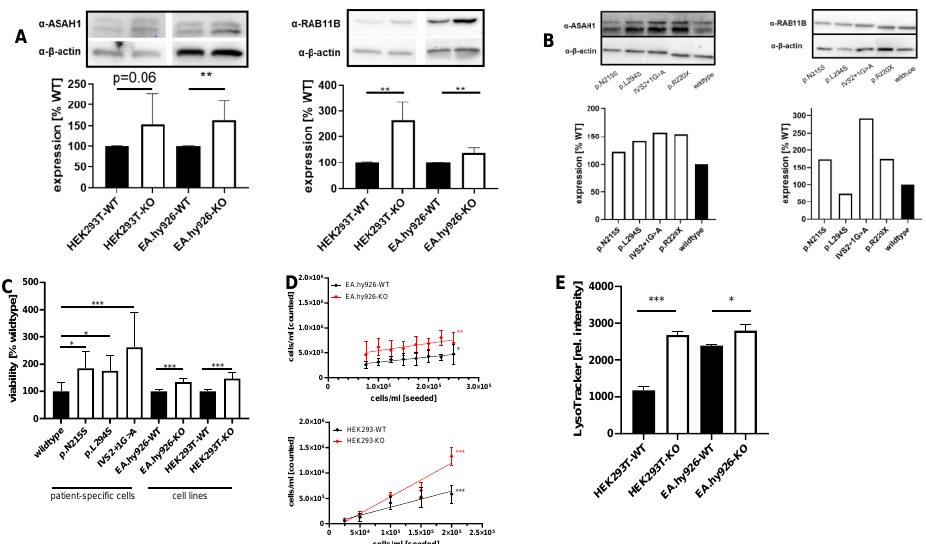
Figure 6: Expression of GOIs and functional analyses of involved pathways in other FD cell lines and patient-specific fibroblasts. A) ASAH1 and RAB11B expression in kidney epithelial HEK293T, endothelial EA.hy926 cells and B) in patient-derived fibroblast cells compared to a healthy control (wildtype). C) Increased cell viability and D) proliferation in AGAL-deficient cells. E) Increased lysosomal volume in AGAL-deficient EA.hy926 and HEK293T cells. *p<0.05, **p<0.01, ***p<0.001.